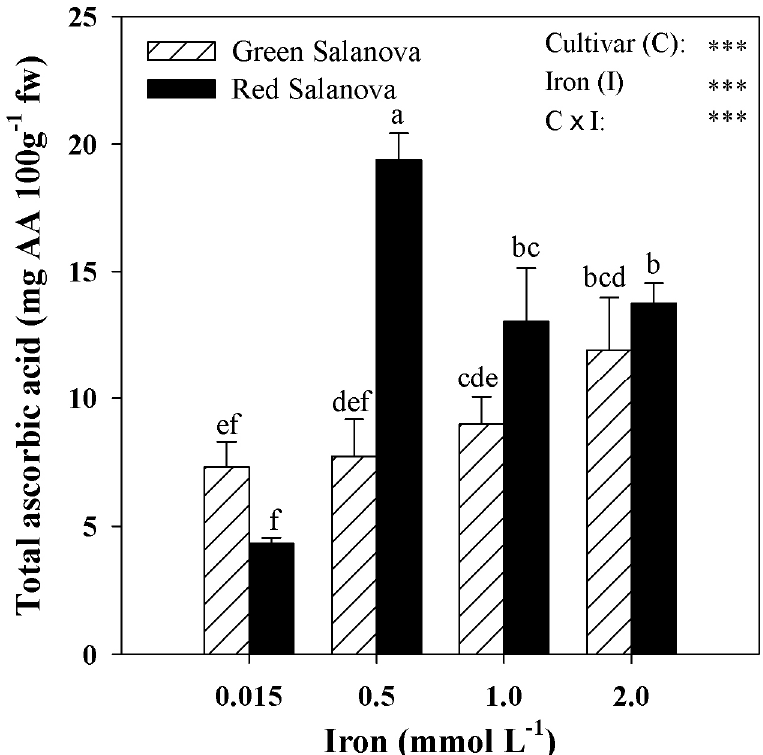
Figure 2. Effects of cultivar and Fe concentration in the nutrient solution on total ascorbic acid in lettuce leaves. Different letters indicate significant differences according to Tukey’s HSD test ( P = 0.05). The values are means of three replicates. Vertical bars indicate ± standard deviation of means.